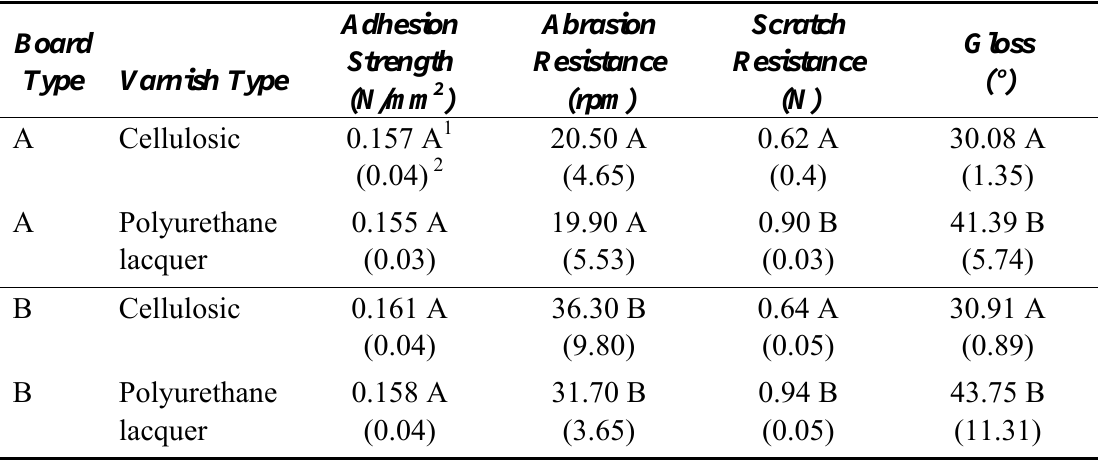
Table 6 . Adhesion strength, abrasion and scratch resistance, and gloss properties of the produced HDPE based wood plastic composites.